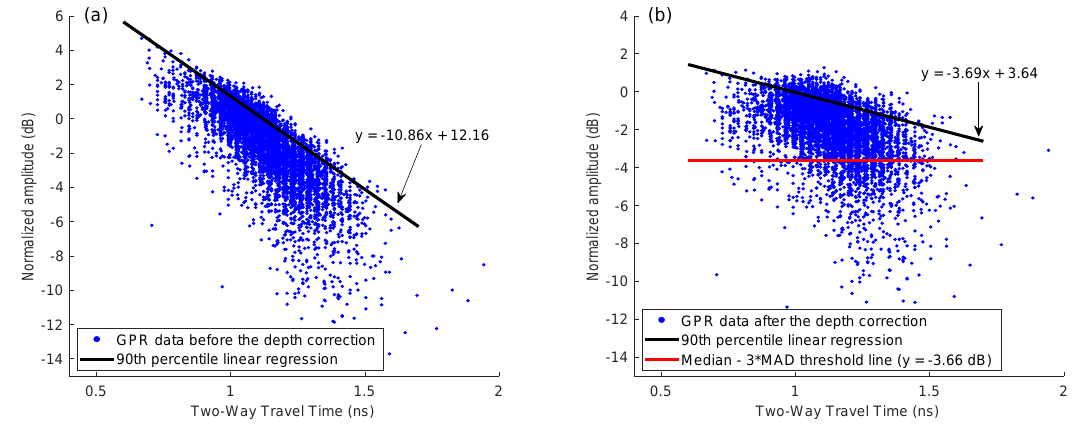
Figure 10. Scatter plot of GPR data points from the straight bridge ( a ) before and ( b ) after amplitude-depth correction, and threshold line.